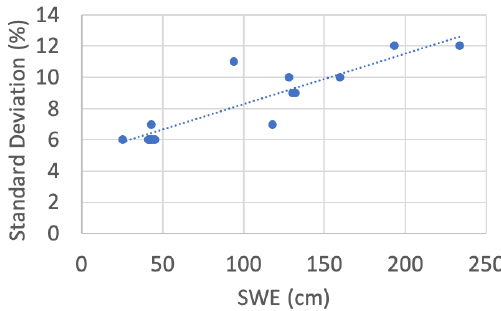
Figure A1. Relationship between the standard deviation (%) of SWE measurements as a function of SWE (mm) based on snow core, derived from Gugerli et al. (2019) (data from Plaine Morte Glacier, Switzerland). Results show an uncertainty of 6% for SWE of the order of 250–500mm, about 10% for SWE between 1000 and 1500mm, and 12% for SWE between 2000 and 2500mm.